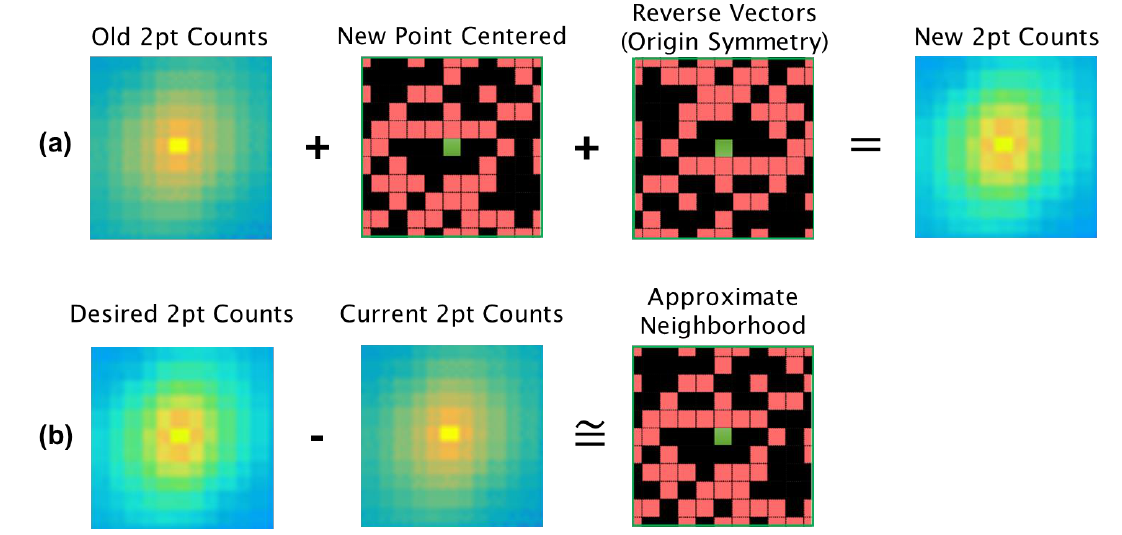
Figure 6. ( a ) The update concept for two-point statistics is shown graphically. ( b ) The graphical equation is rearranged to yield an approximation of the ideal neighborhood a pixel to be placed should possess.